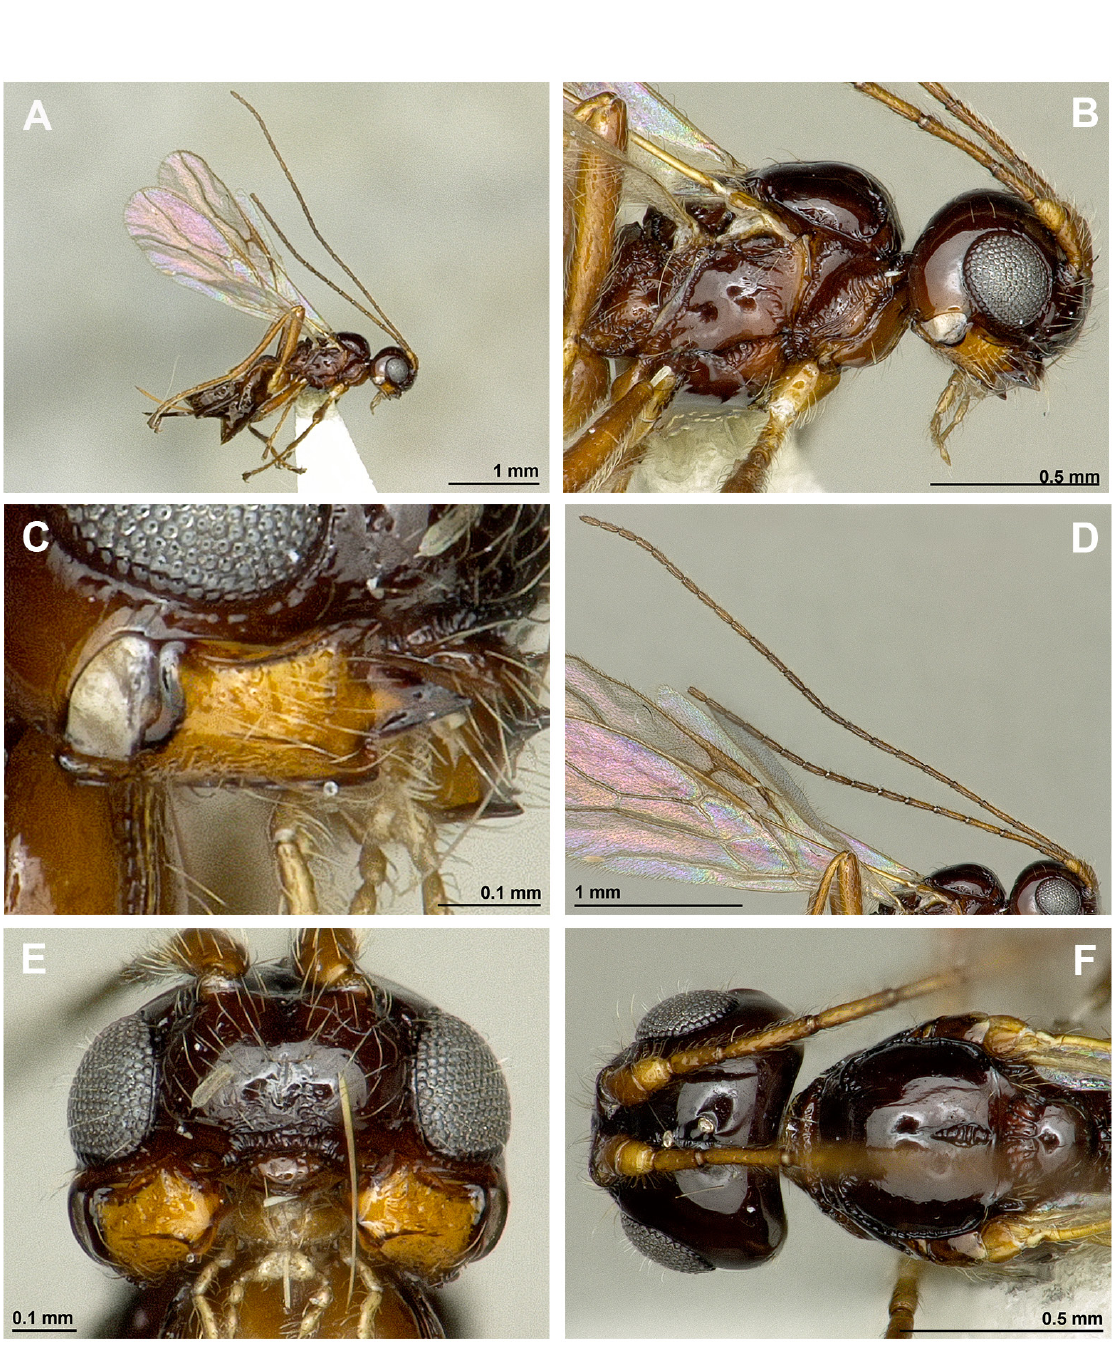
Fig. 74. Asobara victoriana Peris-Felipo, sp. nov., ♀, holotype (BMNH). A . Habitus, lateral view. B . Head and mesosoma, lateral view. C . Mandible. D . Antenna. E . Head, front view. F . Head and mesoscutum, dorsal